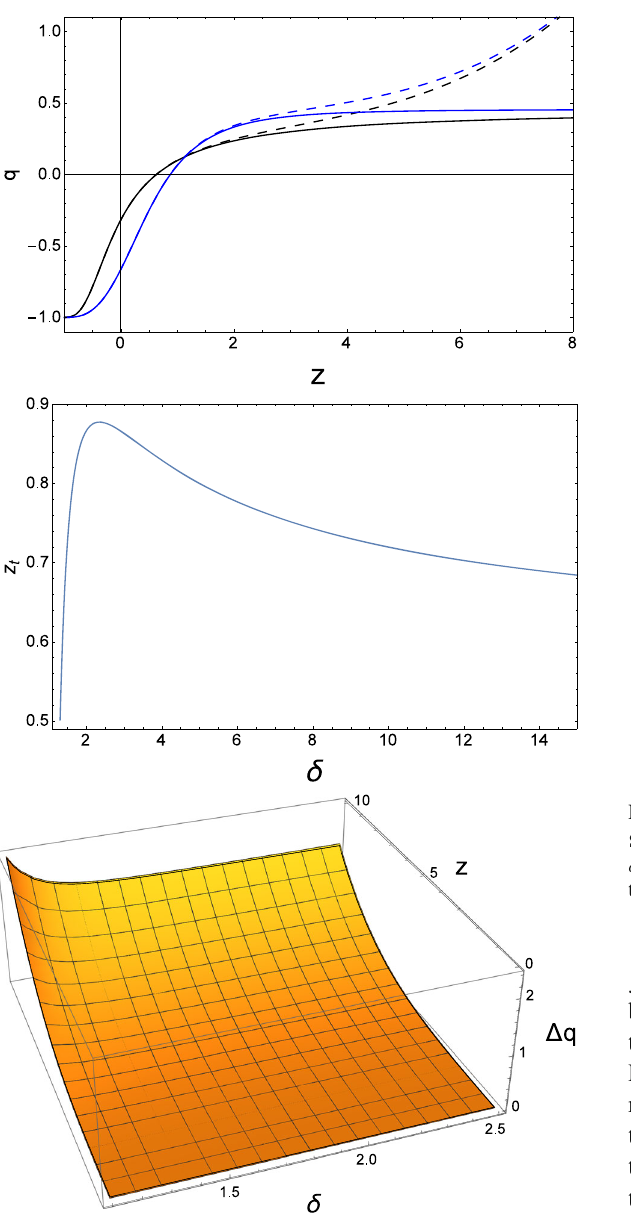
Fig. 11 Upperpanel:Theevolutionof q versusredshiftparameter z for (cid:5) 0 = 0 . 73, (cid:5) = 2 . 47 × 10 − 5 , b 2 = 0 . 03, b 2 = 0 . 01, δ = 1 . 4 (black r 0 D 1 2 curves) and δ = 2 . 2 (blue curves). A dashed (solid curve) represents the corresponding evolution of deceleration parameter when radiation fluid is present (absent). Middle panel: Transition redshift against δ param- eter for the same values of model parameters as above figure. Lower panel: The behavior of the difference between deceleration parameters with and without considering radiation as a function of redshift and δ parameter